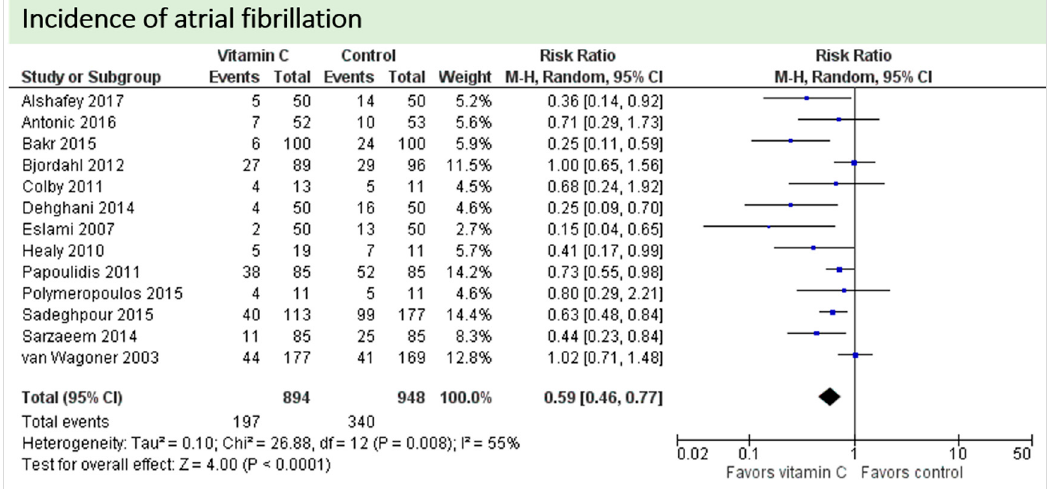
Figure 5. Incidence of postoperative atrial fibrillation.